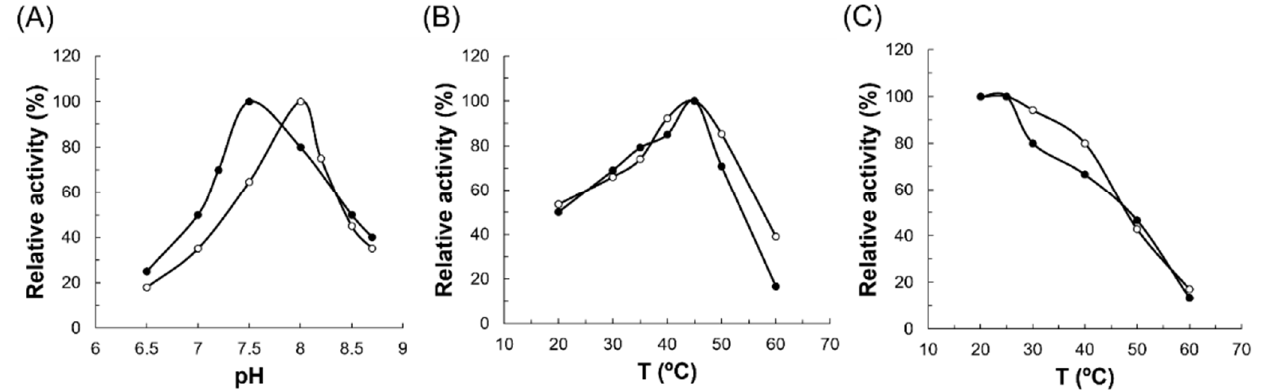
Figure 7. ( A ) Effects of pH on the activity of recombinant D2HGDH Ec and D2HGDH Pa ; ( B ) effects of temperature on the activity of recombinant D2HGDH Ec and D2HGDH Pa ; ( C ) temperature stability of recombinant D2HGDH Ec and D2HGDH Pa . D2HGDH Pa is depicted by dark circles ( • ). D2HGDH Ec is depicted by open circles ( (cid:35)